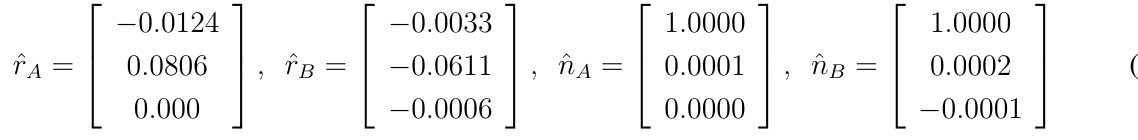
Table 3. RMS position error comparison of different calibration parameters (unit: